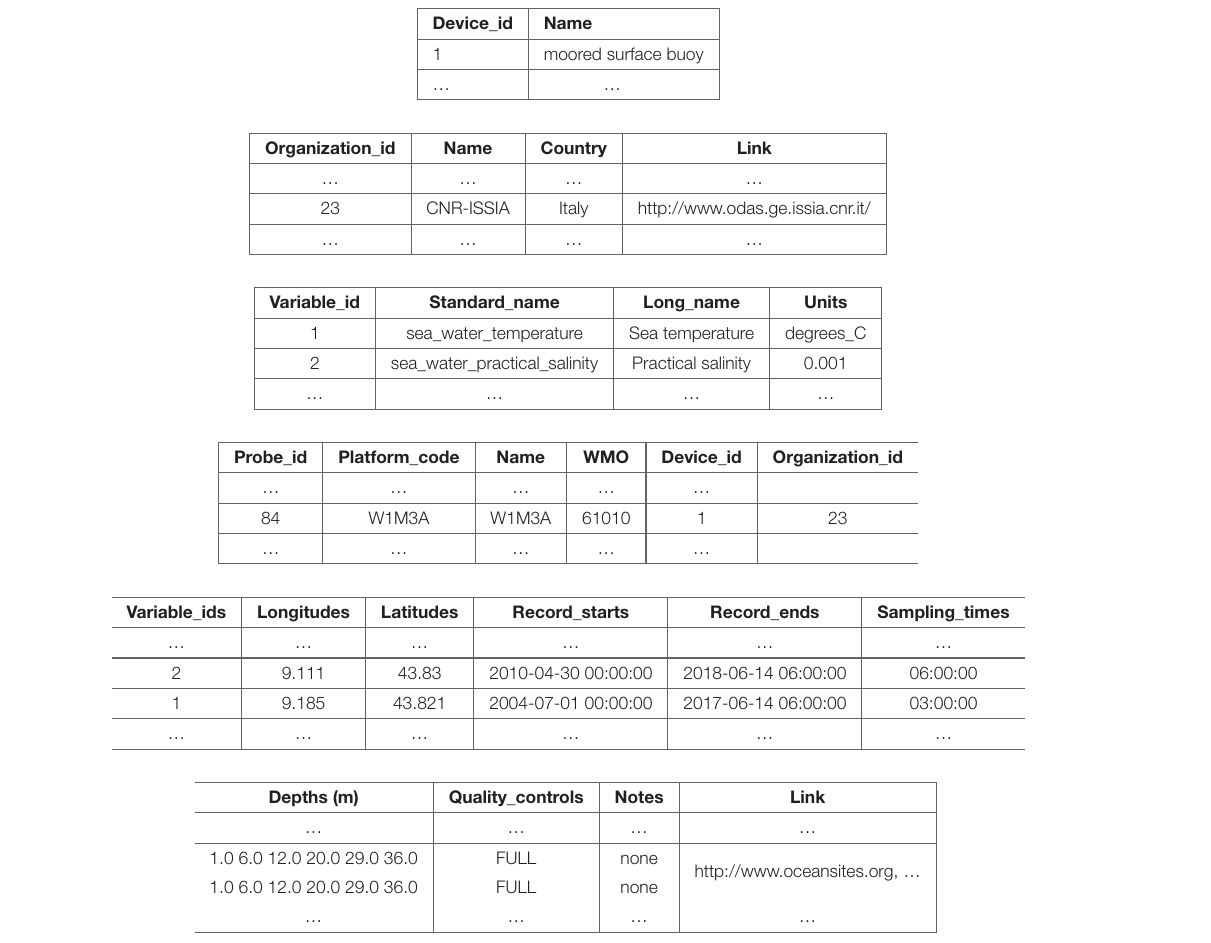
• Platform information: unique identifier (ID), platform_code, device type ID, data originator ID, variable IDs (relations with the other tables of the database), and web link; • Data record information: averaged latitude and longitude positions over time dimension, start and end dates, median of the sampling time, standard depth levels array, and QC